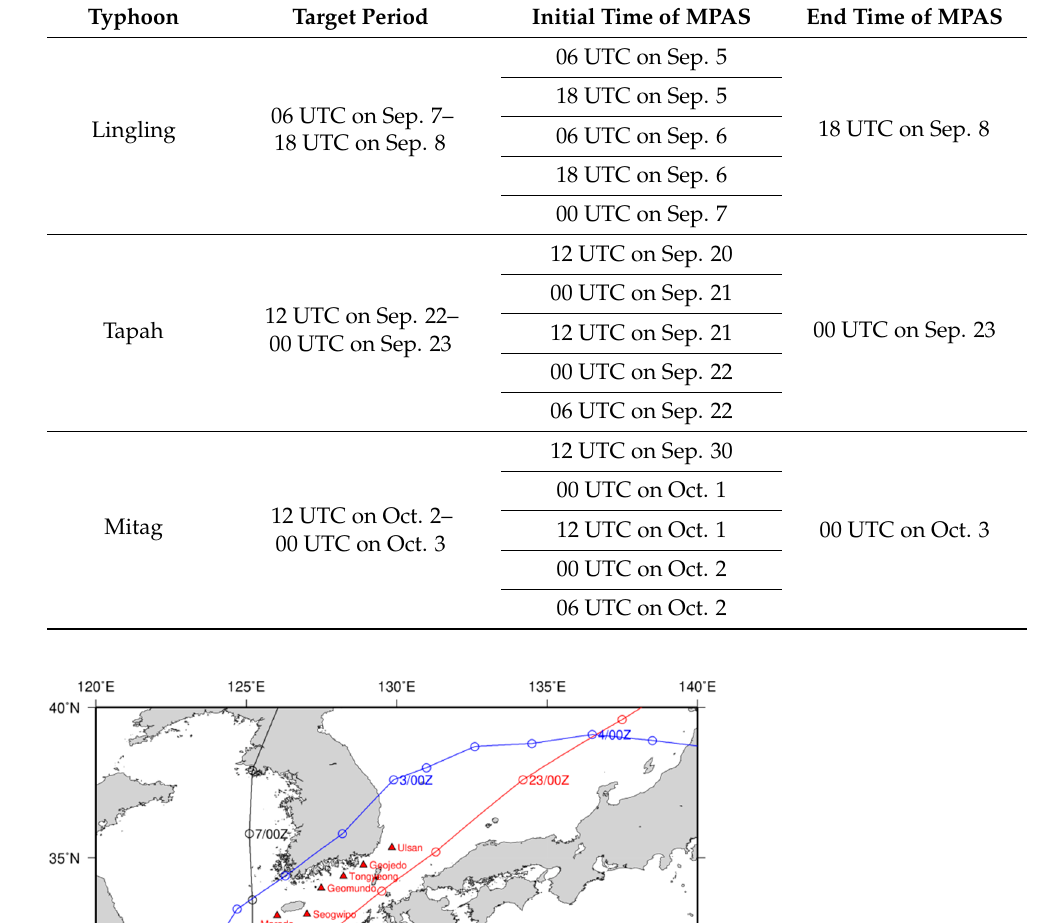
Table 2. List of three selected typhoons that occurred in 2019 and their MPAS simulation periods for the target periods.